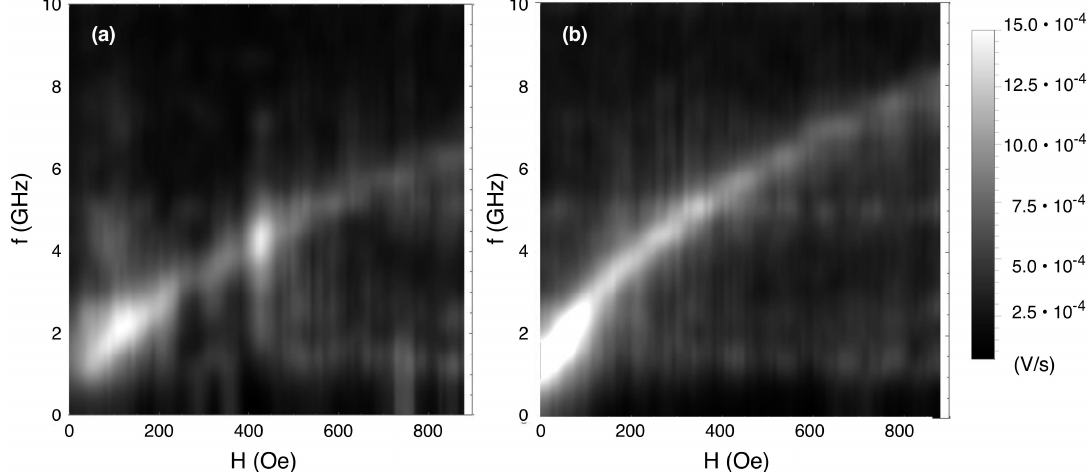
Figure 10. Dispersion measurement in the Ni 80 Fe 20 antidot array ( a ) and in the bi-component nanostructured system ( b ).